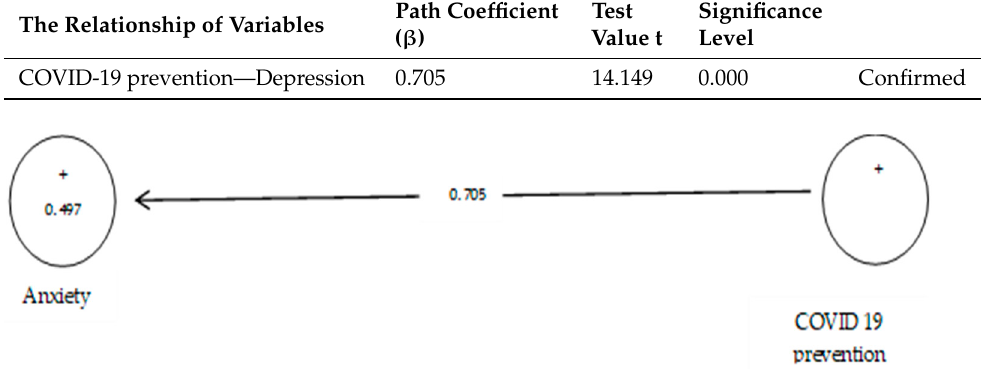
Figure 10. The fourth sub-hypothesis model includes factor load coefficients.